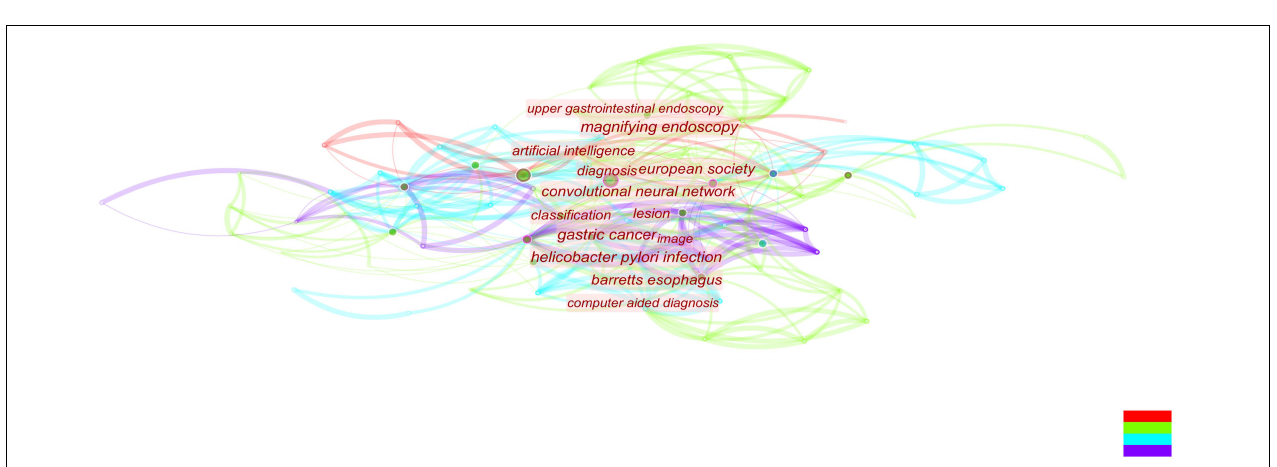
FIGURE 8 | It can be seen from the revised figure that the literature studies on the combination of early gastric cancer, artificial intelligence, and endoscopy have taken place in recent 3 years, and the main research hotspots in 2022 are focused on screening, i.e., applying artificial intelligence to endoscopy to screen early gastric cancer.